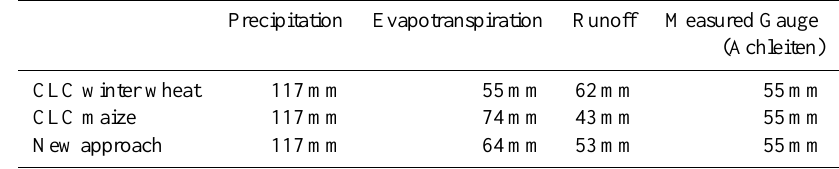
Table 6. Water balance of three PROMET simulations using the CLC winter wheat, the CLC maize and the new land use/cover approach in comparison to the measured gauge in Achleiten as mean values from 1971–2000 for the month of